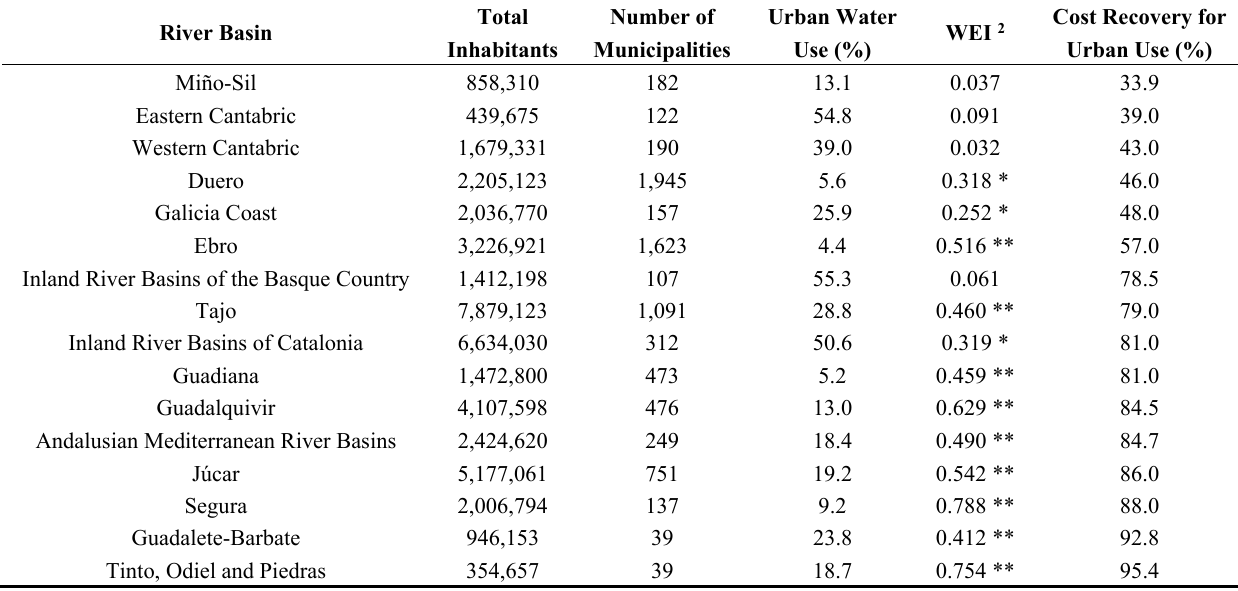
Table 2. Cost recovery of urban water services per Spanish River Basin 1